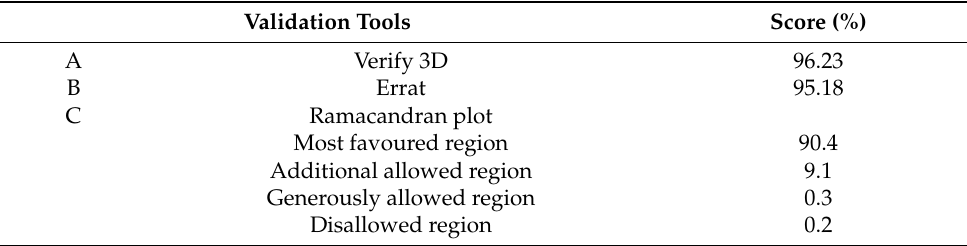
Table 1. The summary score for the predicted structure of A. geothemalis ALDH using online web tools. Validation